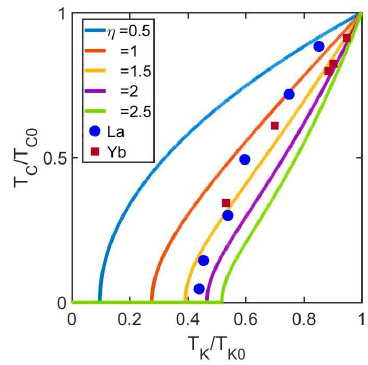
Figure 3: Relationship between T and T . We demonstrate the relationship be- c K tween T and T for several values of the exponent η (from Eq. (13)). Interestingly, c K T vanishes below some critical value of T , where the cutoff value decreases with c K decreasing η . T , T are normalized to some highest values of T c K for each values of η . For CeCoIn , Yb and La dopings [ 55 ] are known to modulate 5 the valence fluctuation strength T , giving an intriguingly similar T K tionship, as predicted by our theory in Eq. (13). Experimental values agree well for η ∼ 1 − 1.5 for ¯ ξ = f